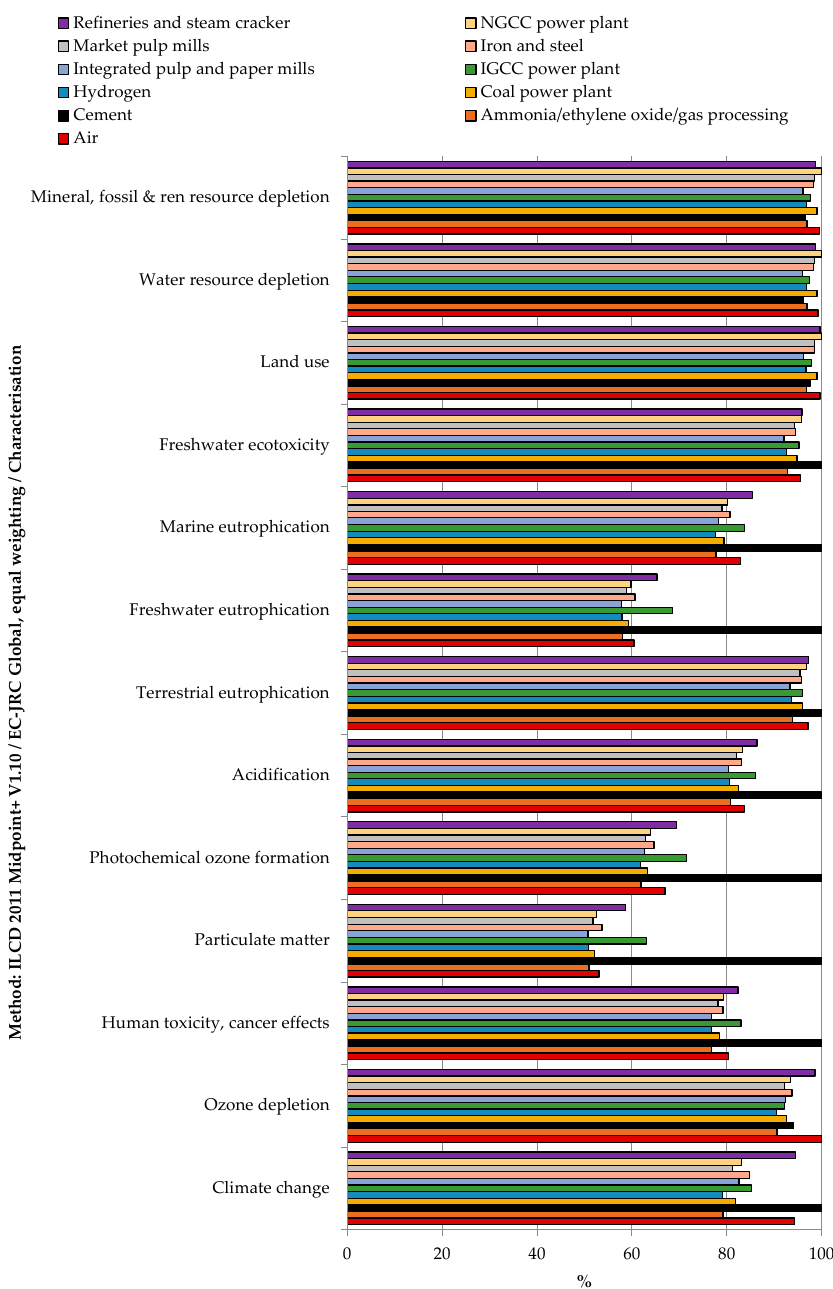
Figure 5. Relative impact assessment for 1 kg SNG production from different CO 2 sources.